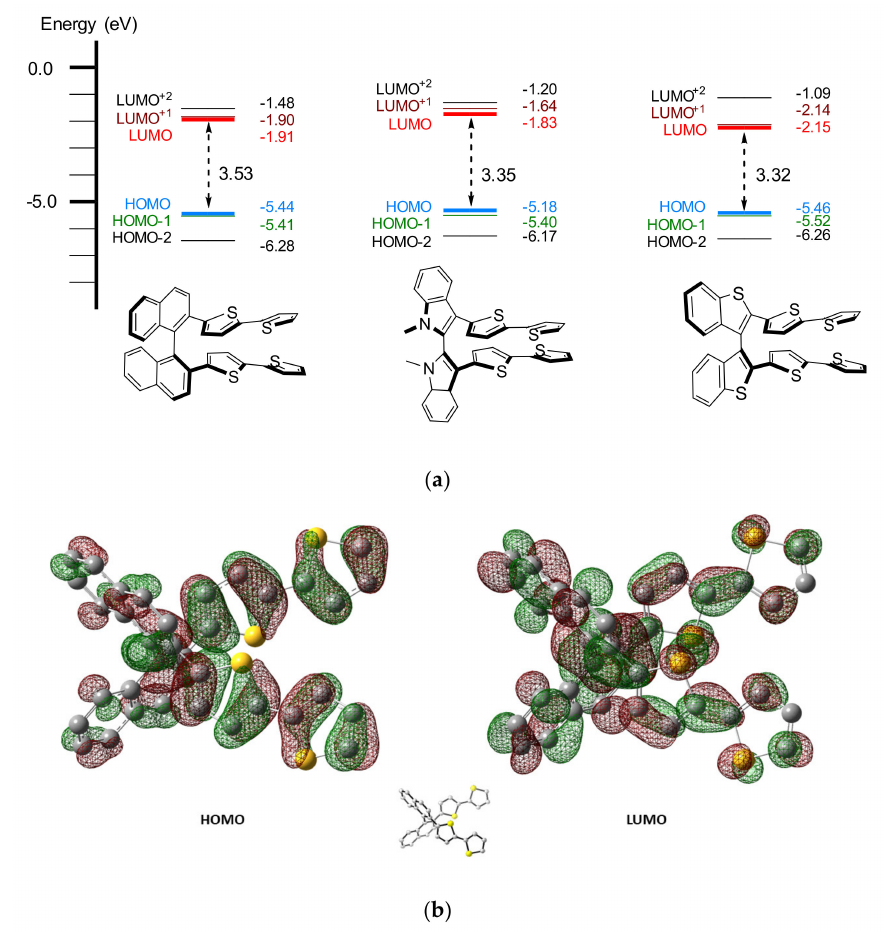
Figure 5. ( a ): DFT-calculated molecular orbital energies of ( S )-Naph 2 T 4 , ( S )-( N -Me-IND) 2 T 4 and ( S )-BT 2 T 4 . ( b ): Frontier molecular orbital topologies for ( S )-Naph 2 T 4 . Contours of ( S )-Naph 2 T 4 molecular orbitals were plotted using